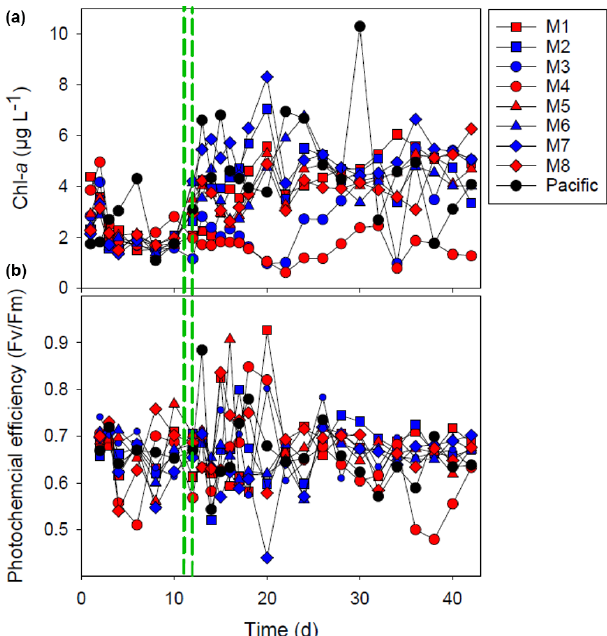
Figure 3. The chlorophyll- a (Chl- a ) concentration (a) and the pho- tochemical efficiency (b) . The red and blue colors denote the meso- cosm bags with the addition of water with a low (closer to shore) and very low (further offshore) oxygen minimum zone (OMZ) sig- nature, respectively. The green dashed lines denote the time of OMZ-water addition. Pacific denotes measurements from water col- lected next to, but outside of, the